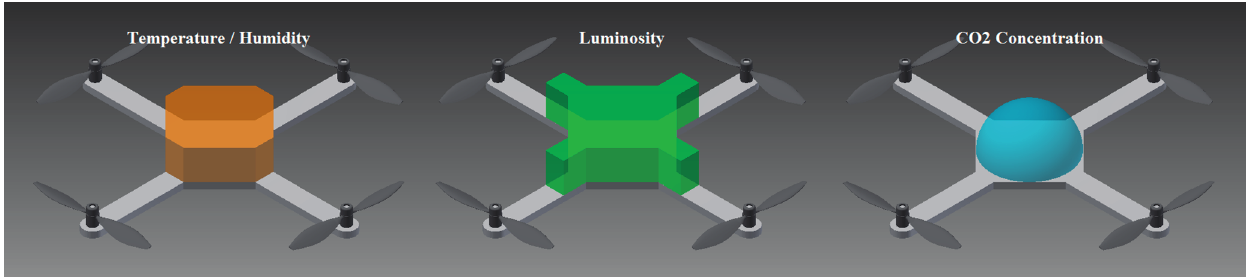
Figure 8. Proposal of sensor